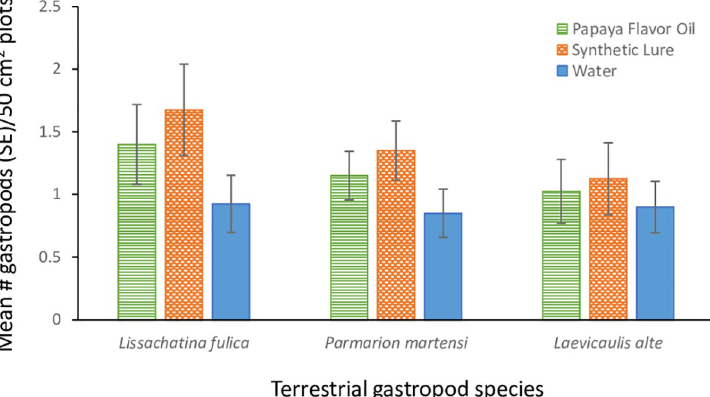
Fig 2. The mean numbers of giant African snails ( Lissachatina fulica ), semi-slugs ( Parmarion martensi ), and black slugs ( Laevicaulis alte ) found inside and adjacent to horticultural containers (n = 10) baited with metaldehyde (Deadline 1 4% metaldehyde) and a canola oil emulsion containing 0.2% papaya-flavored oil (Nature’s Flavors 1 ), or untreated emulsion. Bars represent one standard